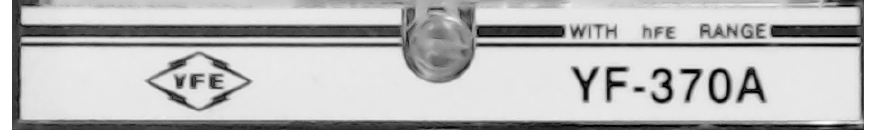
Figure 6. A template ( T A-meter ) used in the EGM method for the horizontal alignment of the A-meter